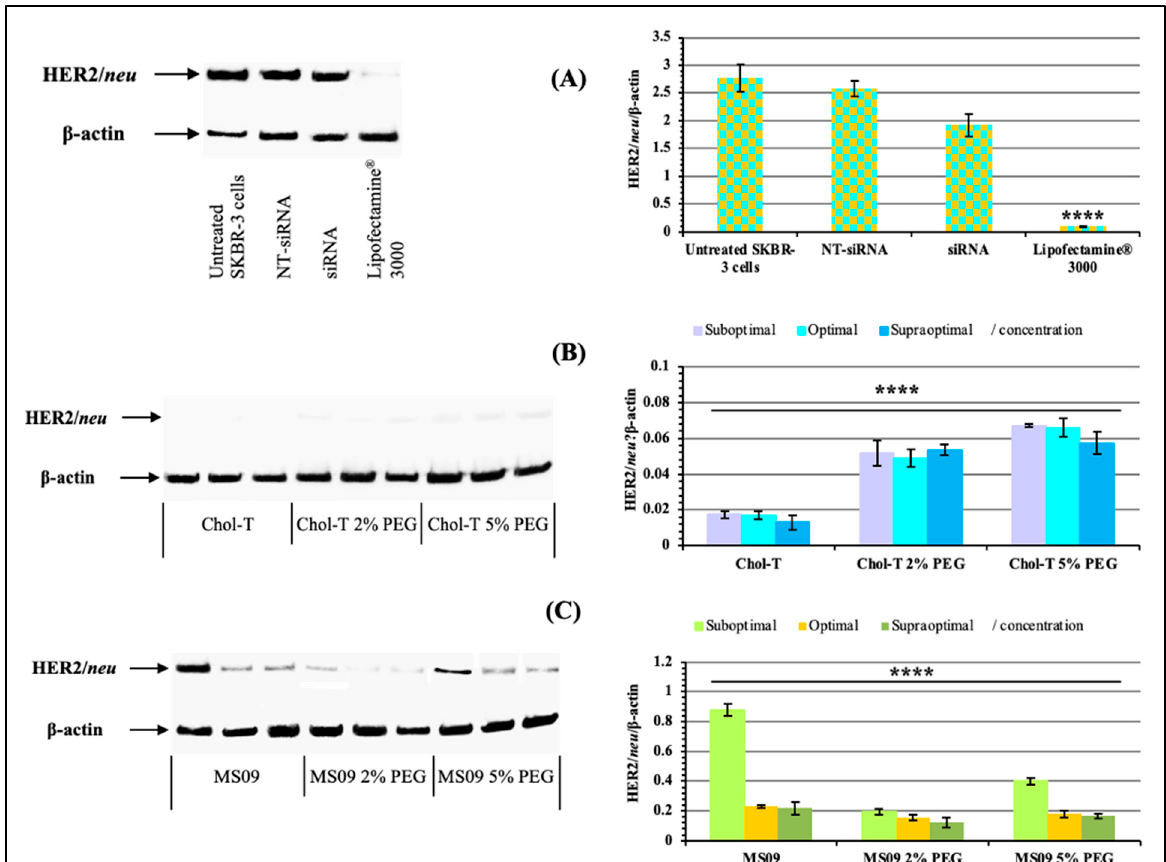
Figure 6. Analysis of HER2/ neu oncoprotein expression by western blotting. ( A ) Non-treated SKBR- 3 cells, NT-siRNA (non-targeting siRNA), and siRNA ( HER2/neu targeting siRNA alone) served as negative controls. Lipofectamine ® 3000-siRNA was included as a positive control, ( B ) SKBR-3 cells were treated with HER2/neu target siRNA: PEGylated and non-PEGylated Chol-T lipoplexes and ( C ) SKBR-3 cells were treated with HER2/ neu target siRNA: PEGylated and non-PEGylated MS09 lipoplexes. HER2/ neu receptor expression was determined in cellular lysates by Western blotting analysis using the HER2/ neu and β -actin antibodies. Graphs represent the HER2/ neu / β -actin normalization ratios. Data are presented as means ± SD (n = 3). **** p < 0.0001 is considered statistically significant vs. the untreated SKBR-3 cell control.